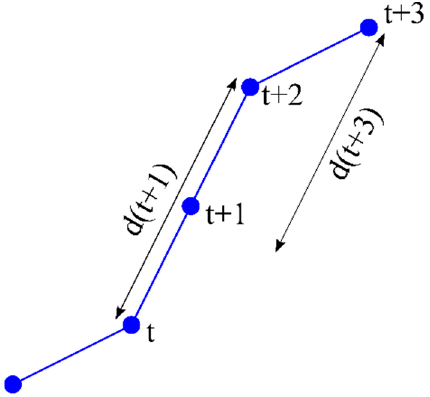
Figure 3. Line plot of voltage rise.